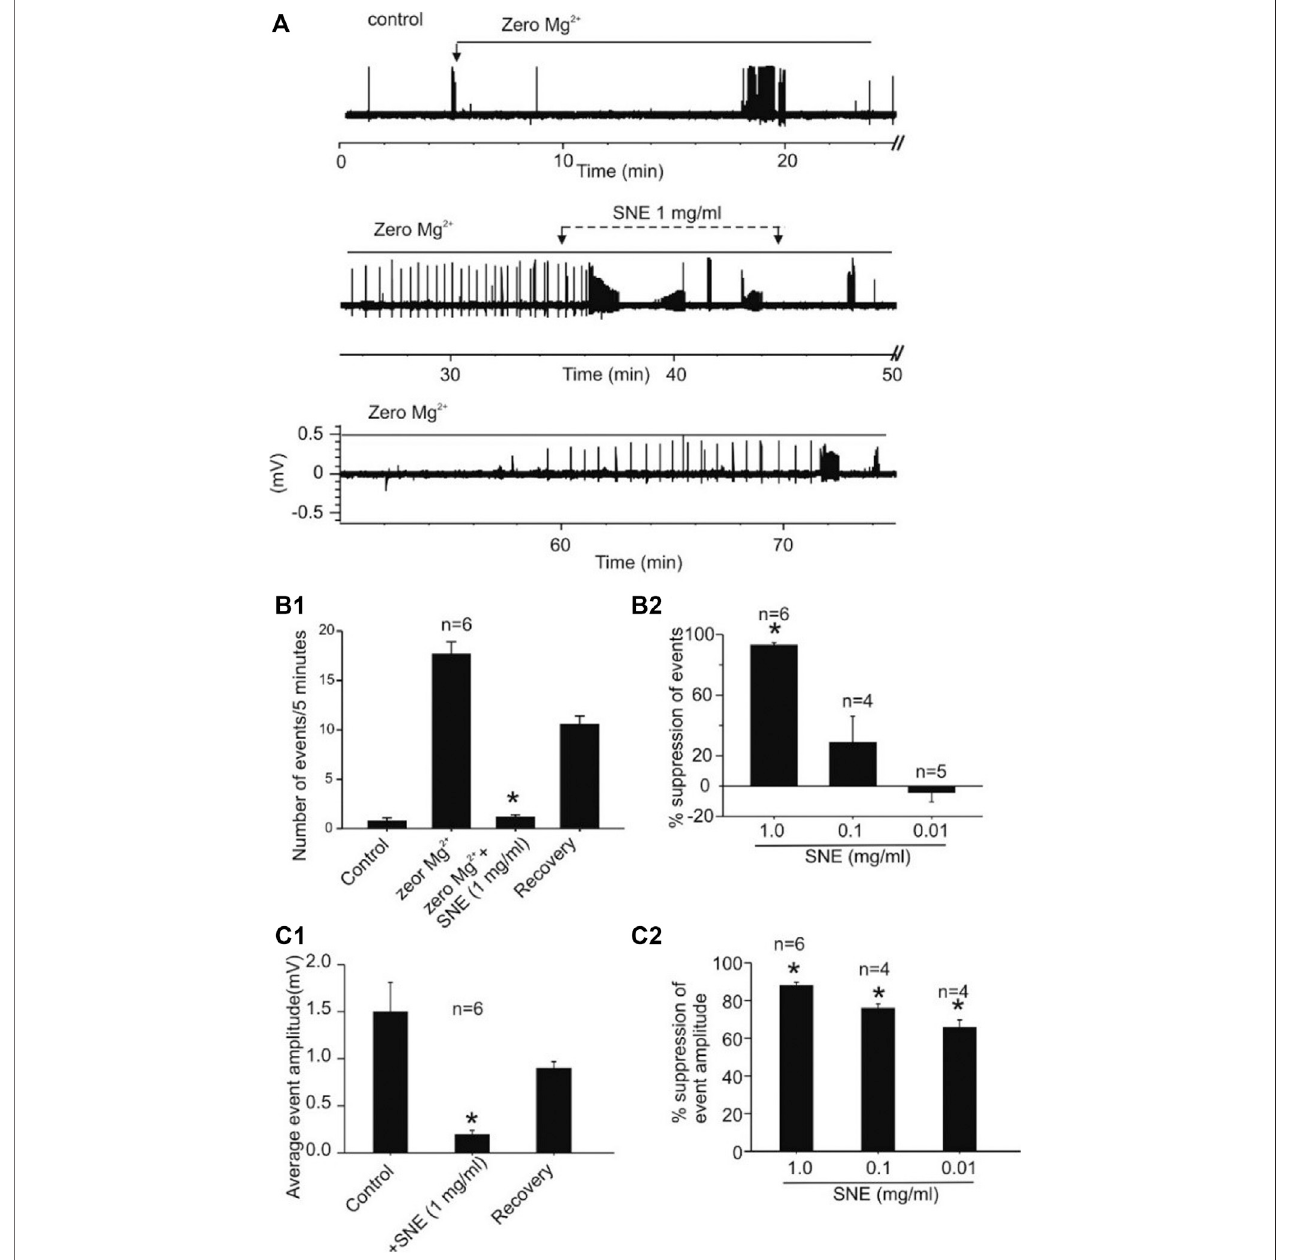
FIGURE8| SNEsuppressesthefrequencyandamplitudeofspontaneousseizureactivityinducedbyzero-Mg 2+ highK + medium. (A) :TraceshowingeffectofSNE on chemically induced seizureactivity. (B1) :Summarybar graphofeffect ofSNE(1 mg/ml) onthefrequencyofspontaneousactivity. (B2) :Summarybar graphshowing concentrationdependenteffectofSNEonseizureactivity. (C1) :SummarybargraphofeffectofSNE(1 mg/ml)ontheamplitudeofspontaneousevents. (C2) :Summary bar graph showing a concentration-dependent depression of event amplitude by